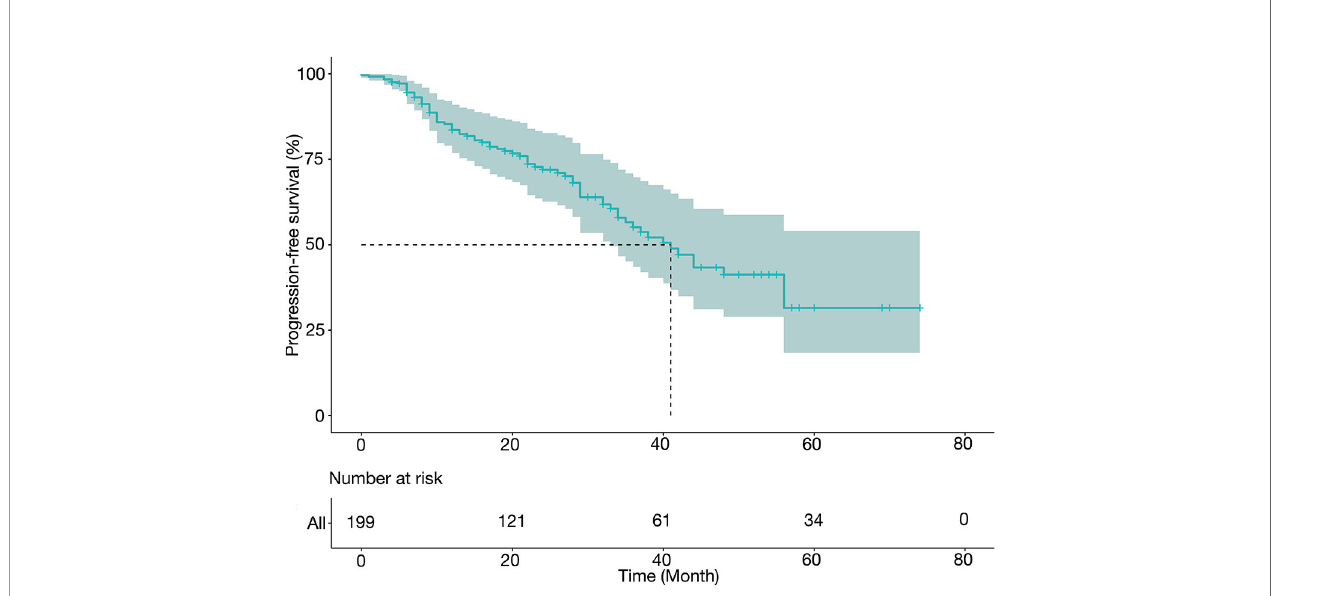
FIGURE 1 | Adjusted progression-free survival (PFS) of the study